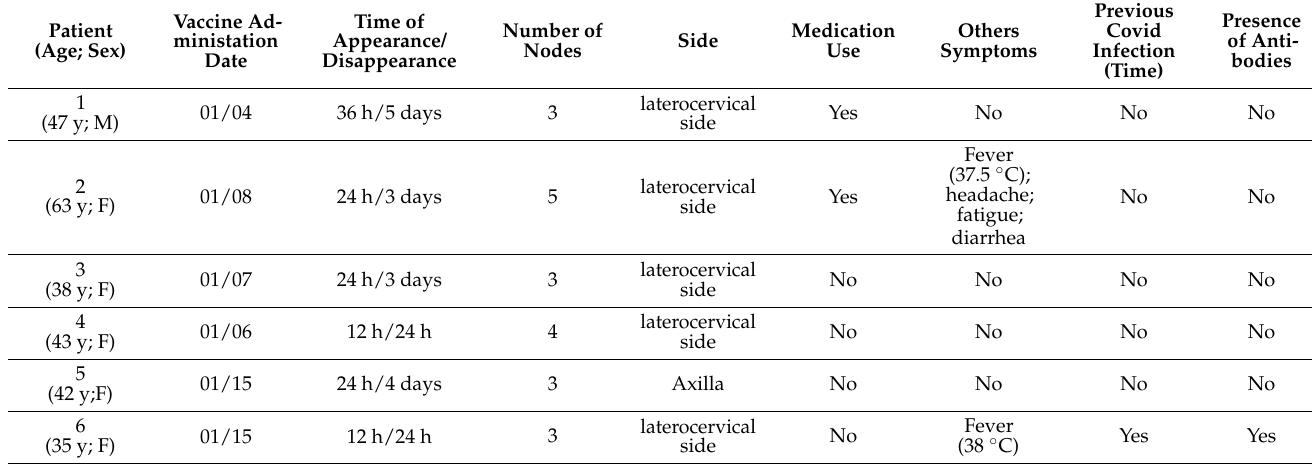
Table 1. Patients study group